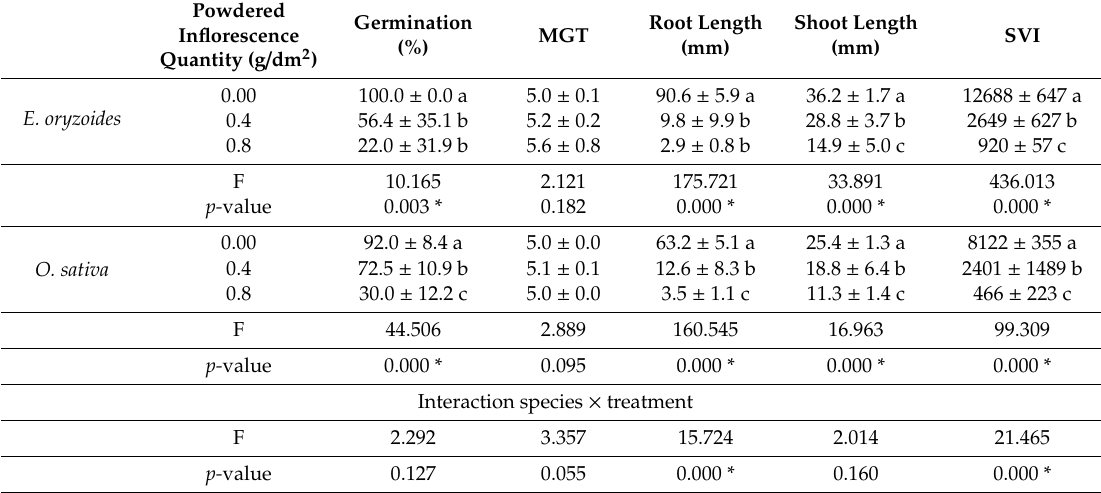
Values are mean ± standard deviation, asterisk and di ff erent letters indicate statistically significant di ff erences at p -value ≤ 0.05 among treatments in each species. F-value and p -value of the ANOVA test. MGT, mean germination time; SVI, seedling vigor index. Table 4. Germination indices measured for E. oryzoides and O. sativa under the e ff ect of di ff erent quantity of L. multiflorum powdered